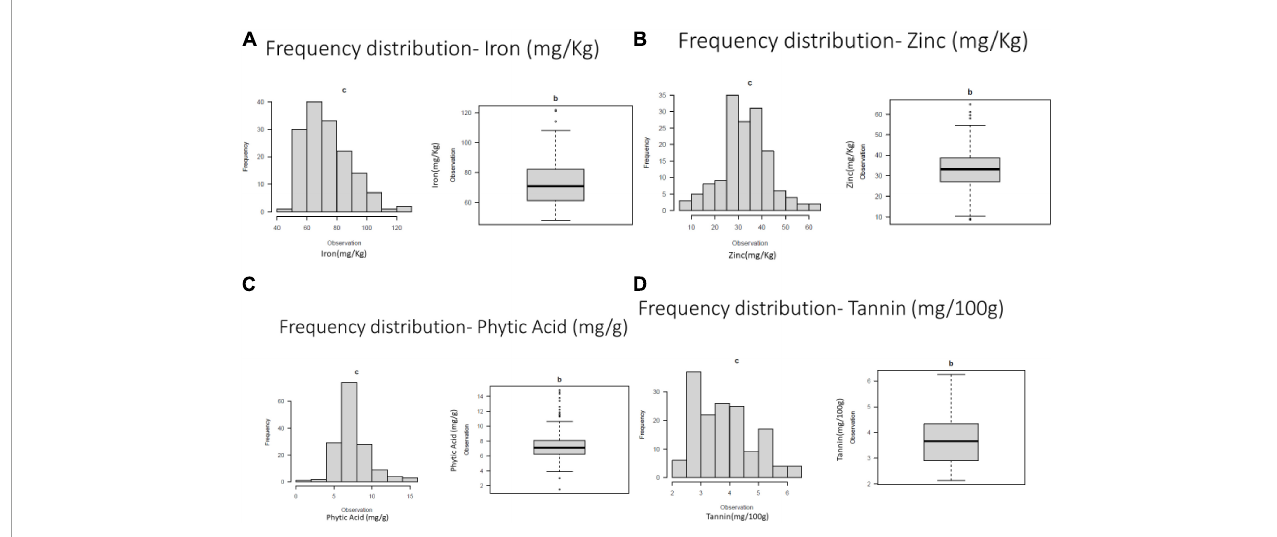
FIGURE1 Frequency distribution of variation for (A) grain iron concentration (B) grain zinc concentration (C) grain phytic acid content and (D) grain tannin content.